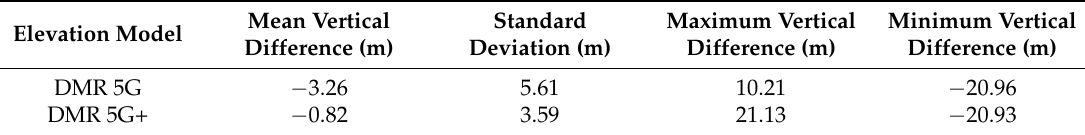
Table 2. Summary data on vertical difference of compared DMR models to the reference model created from the B í l á sk á la 3D object.